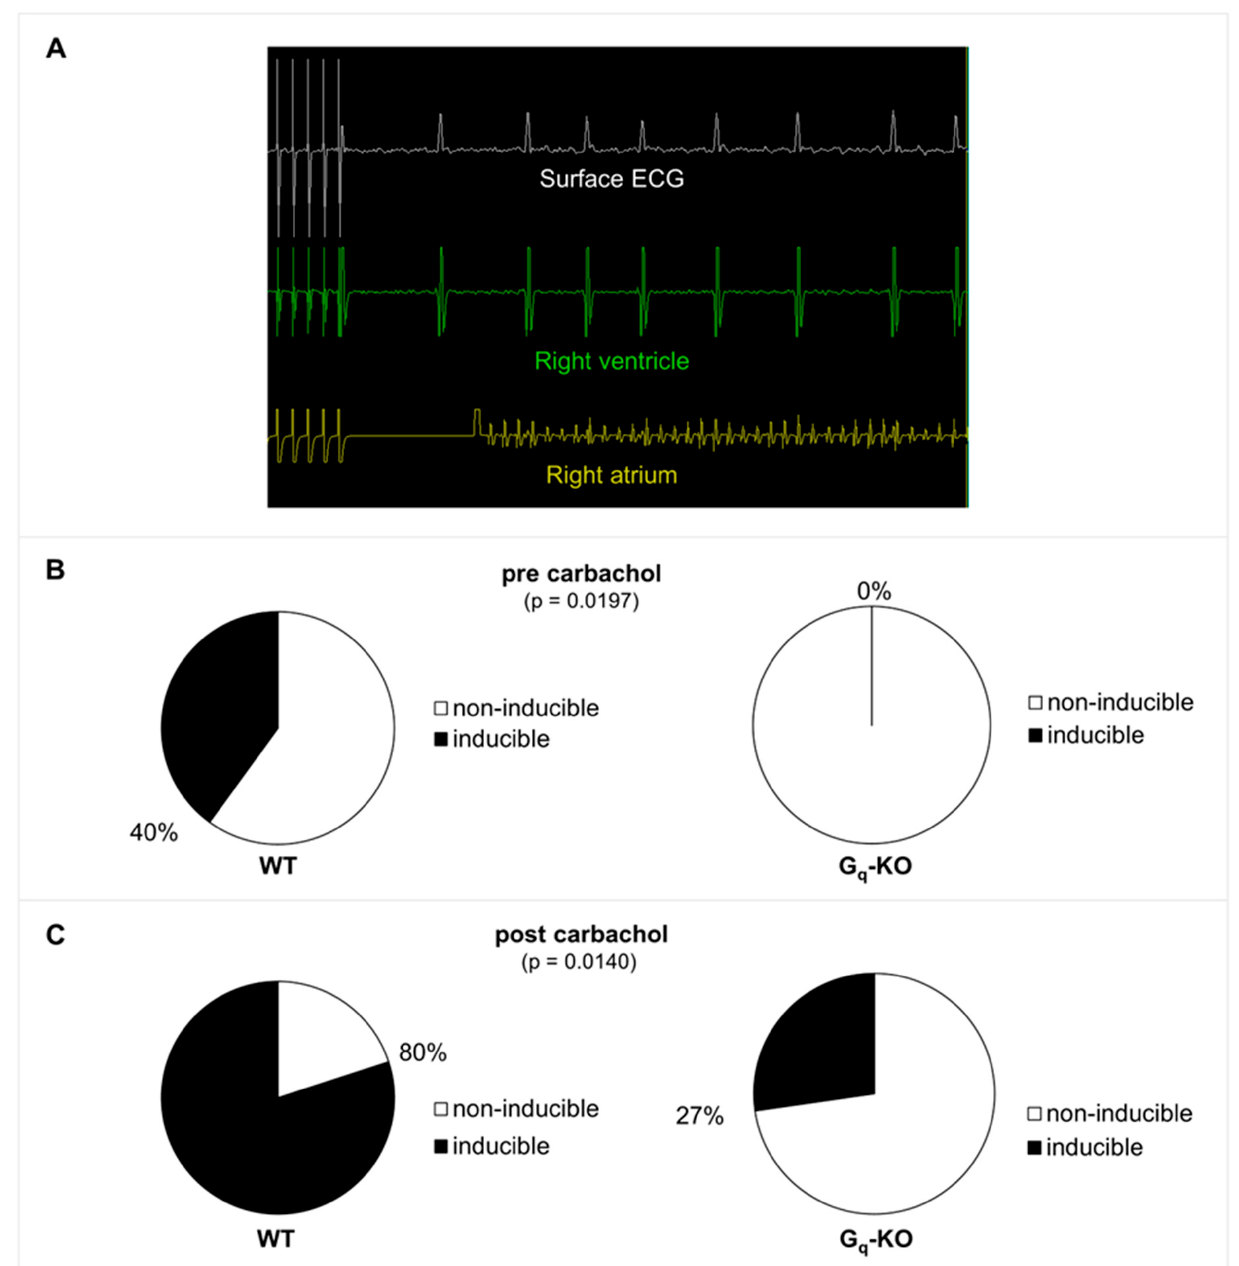
Figure 2. ( A ) Example of AF induction by programmed stimulation in a wildtype control mouse before carbachol injection. There is a short blanking period in the atrial channel following pacing. ( B ) AF inducibility in G q -KO (n = 11) versus control mice (n = 10) before application of carbachol. ( C ) AF inducibility 2 minutes after vagal stimulation with carbachol (intraperitoneal injection of 50 ng/g carbachol).